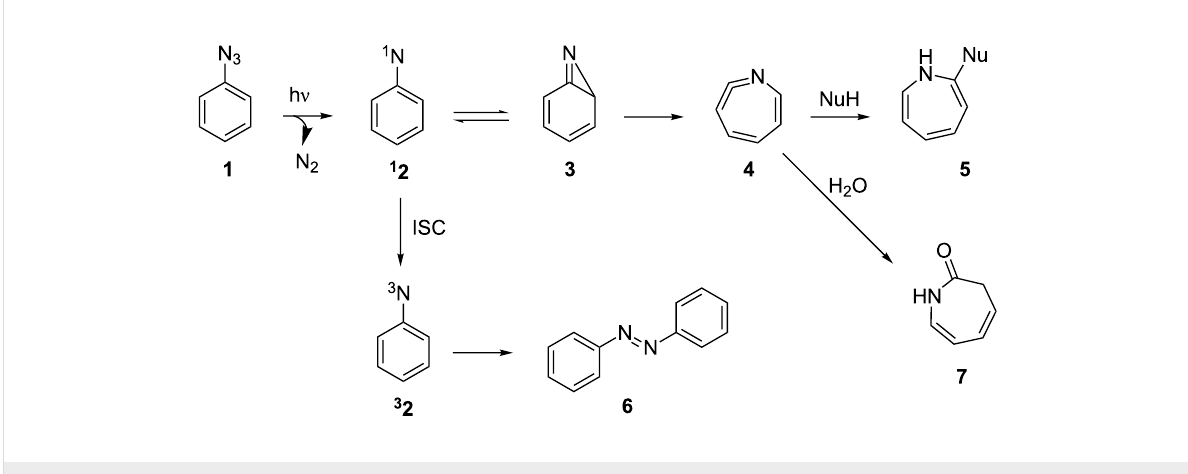
Scheme 1: Products of aryl azide photolysis.